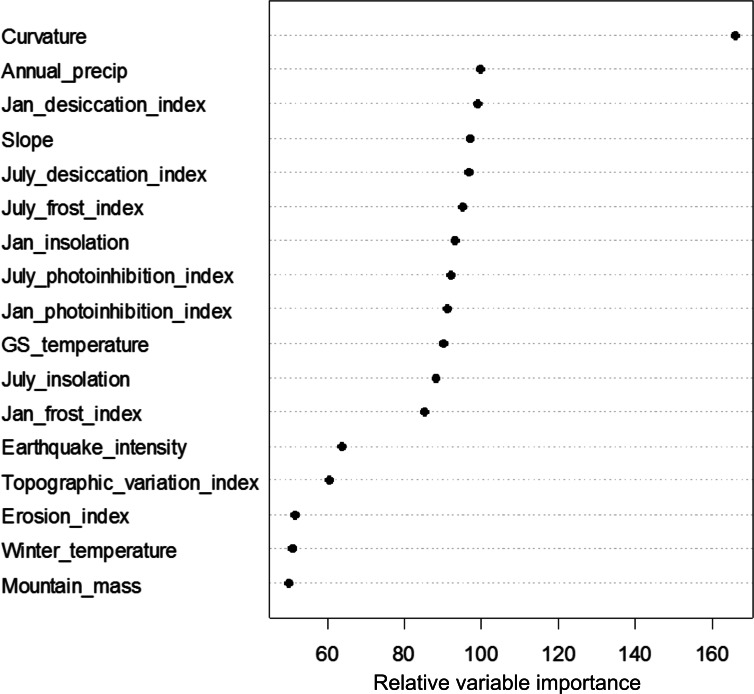
Variable importance plot resulting from the random forest analysis of the effects of 17 explanatory factors on treeline elevation deviation across the 2,100 treeline locations. The relative importance score reflects the percent increase in mean square error that would result from the removal of a given factor from the analysis.